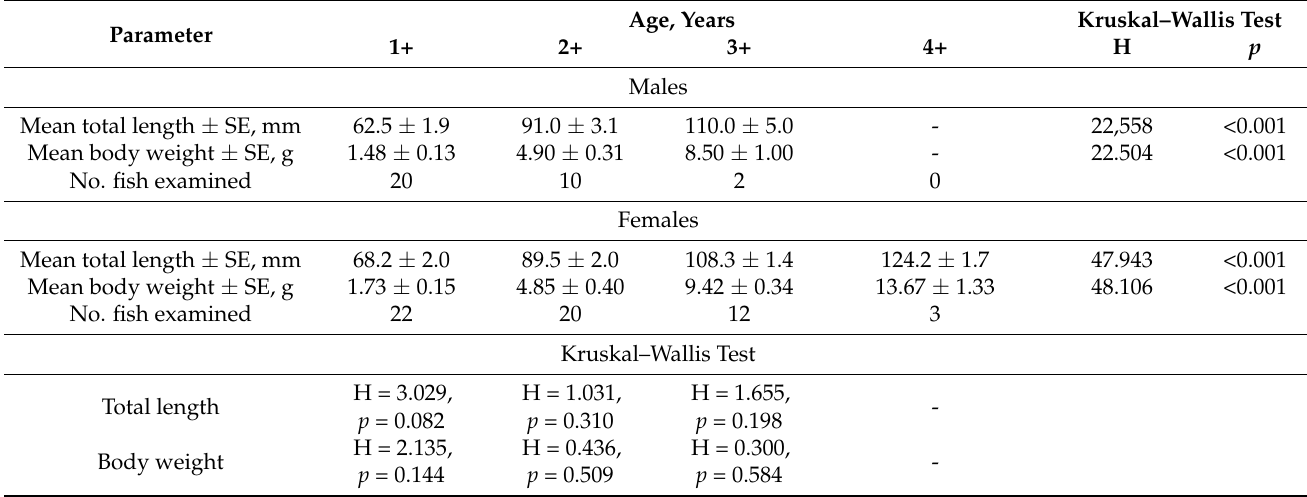
Table 2. Mean total length and body weight of male and female ribbed sculpin Triglops pingelii in different age classes in the Kara Sea, September 2019 (SE = standard